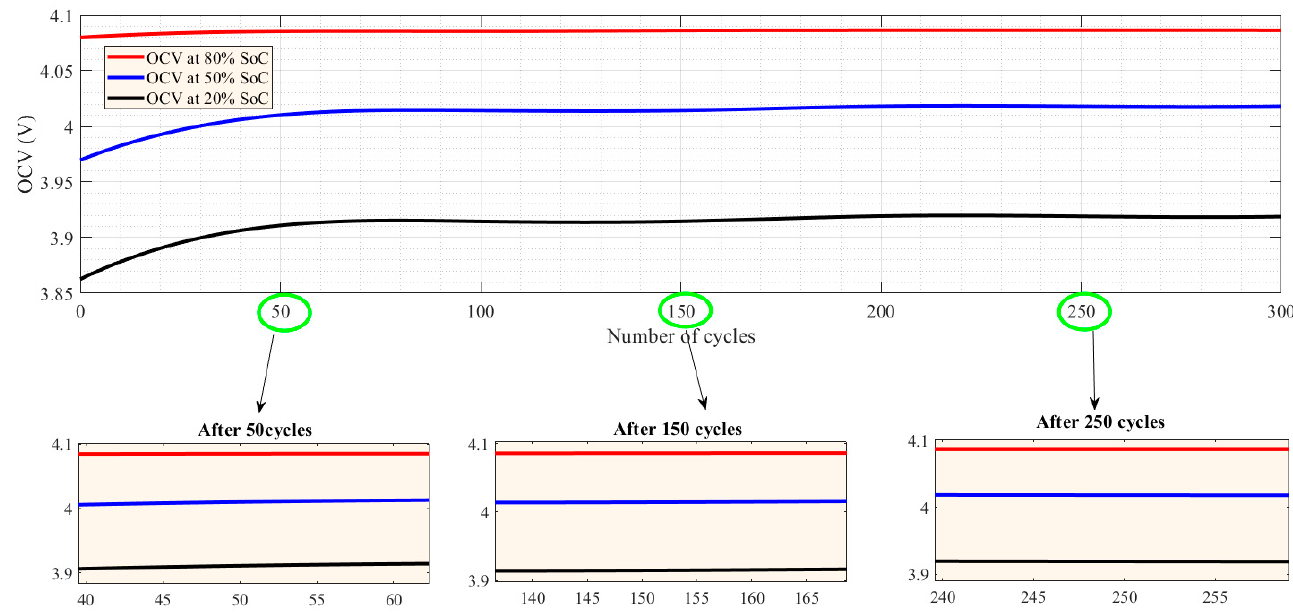
Figure 4. Implemented OCV test to the 3Ah NMC Li-ion battery at 25 °C.